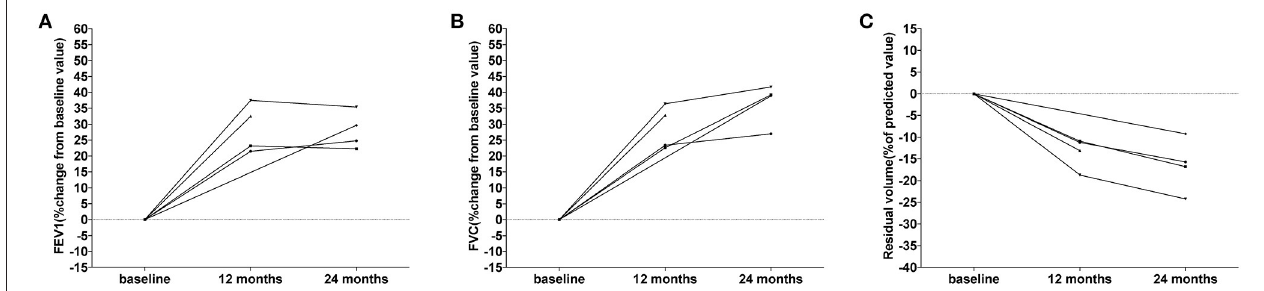
FIGURE 3 | Changes of pulmonary function in the five patients with LAM. (A) The changes of FEV1 from baseline during treatment. Each line represents FEV1 change in one patient. (B) The changes of FVC from baseline during treatment. Each line represents FVC change in one patient. (C) The changes of residual volume from baseline during treatment. Each line represents residual volume change in one patient.